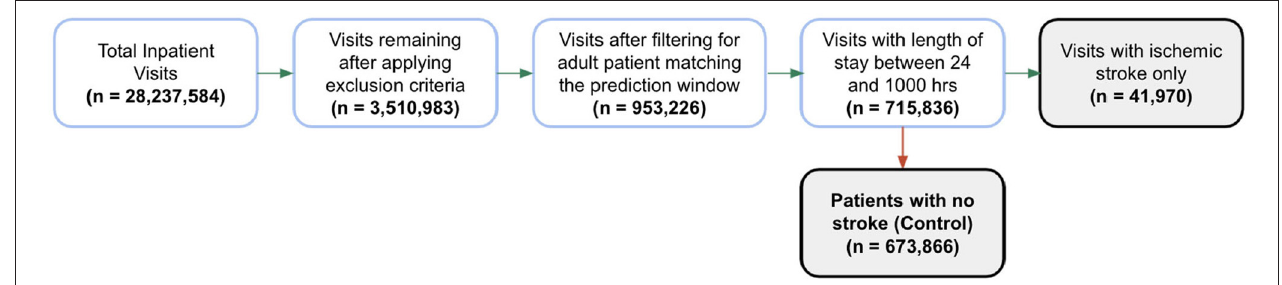
FIGURE 2 | Patient encounter inclusion diagram. Initially, more than 28 million inpatient visits were included in the analysis, then patient encounters were filtered by the exclusion criteria and the prediction window requirements. Forty-one thousand nine hundred seventy patients were identified as positive for ischemic stroke based on our gold standard. The prevalence of ischemic stroke encounters was 5.9% in the training set, 5.8% in the hold-out test set and 6.7% in the external validation